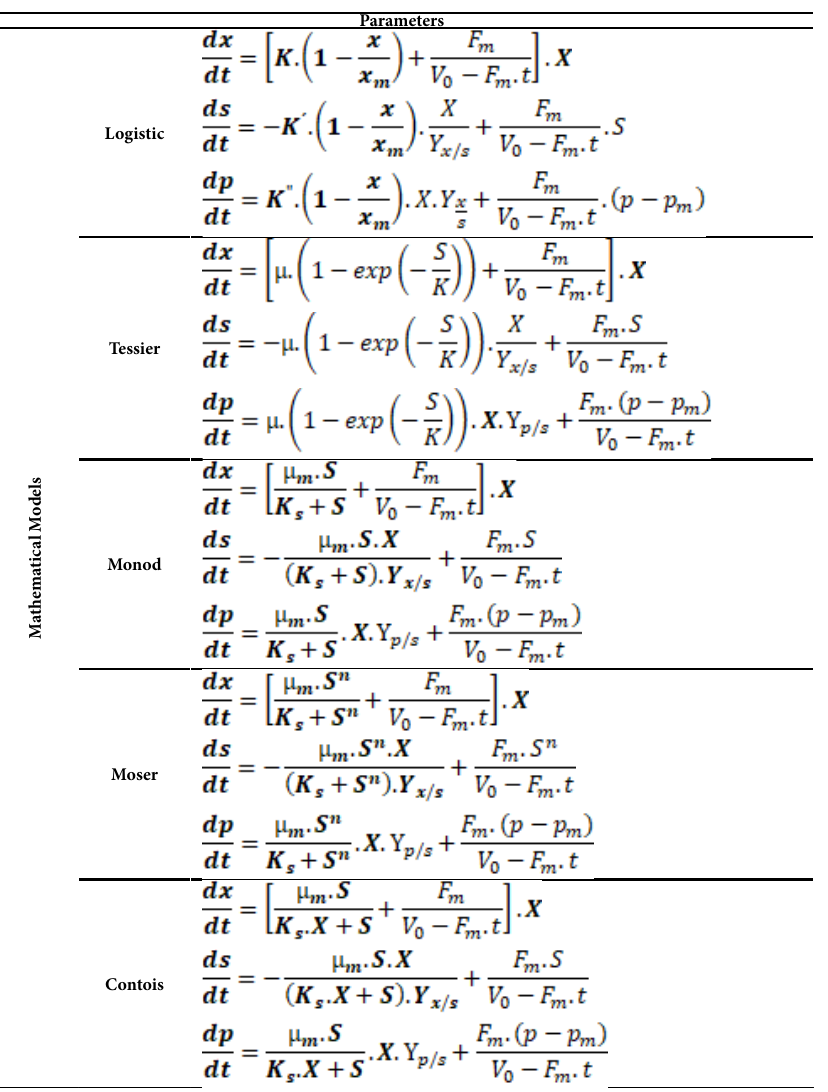
Table 1. Mathematical models for MBR